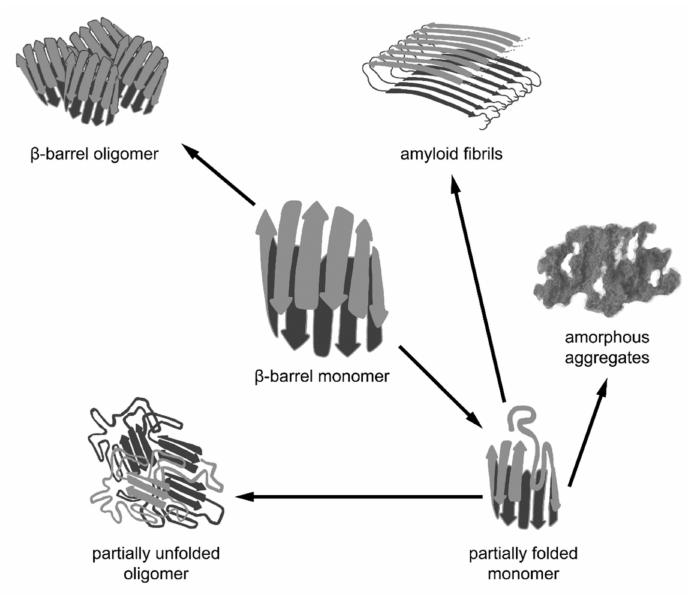
Figure 2. Different pathways of aggregation of β -barrel proteins. β -barrel proteins are prone to associating and aggregating. The formation of functional oligomeric complexes of native proteins is caused by intermolecular interactions between the correctly folded polypeptide chains of β -barrels. However, β -barrel proteins can aggregate not only in their native state via the interaction of correctly folded monomers, but also as a result of the misfolding or distortion of their native structure, leading to the formation of non-native oligomers, amorphous aggregates, and amyloid fibrils. It should be noted that amyloid fibrils formed by some β -barrel proteins may represent a functional native